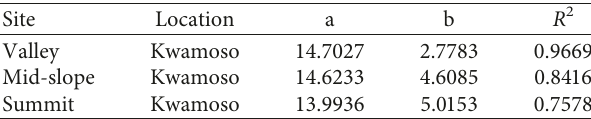
Table 1: Constants and corresponding R 2 produced by Michaelis Menten’s growth